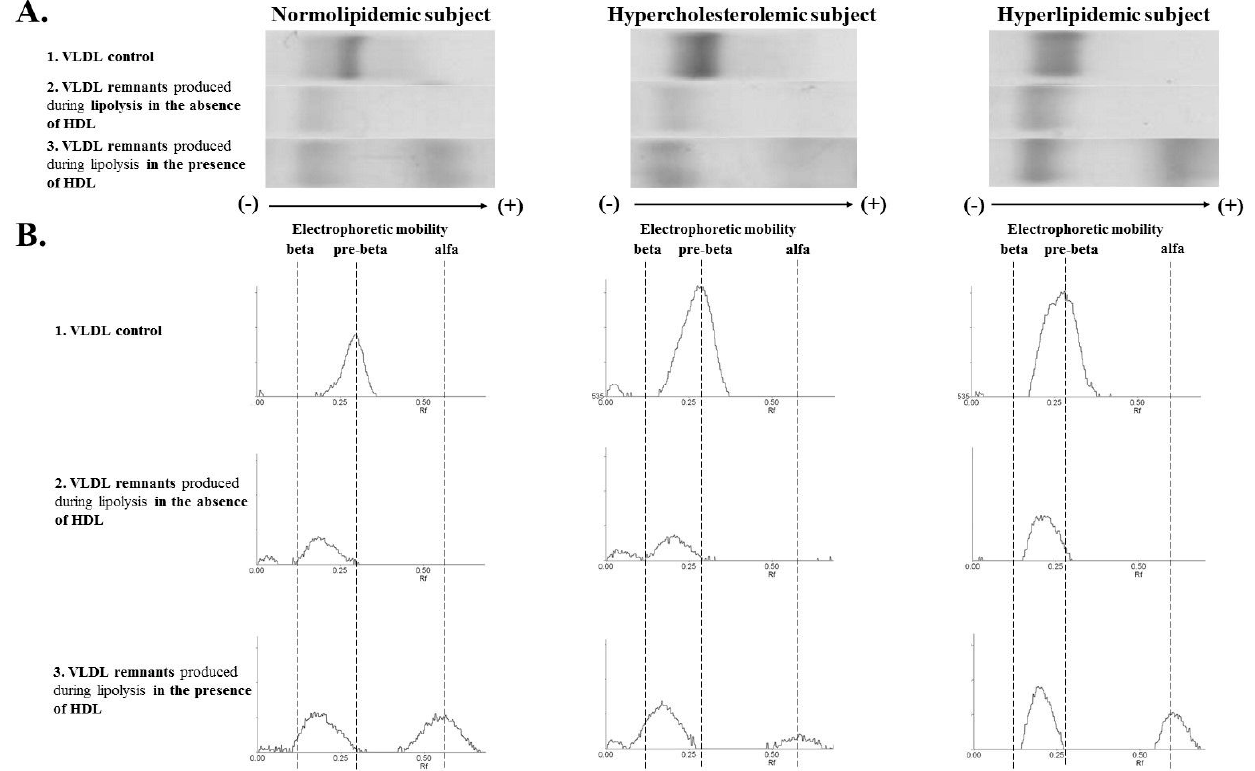
Figure 3. Exemplary electrophoresis ( A ) and electropherograms ( B ) of VLDL control (1) and VLDL remnants produced during LPL-mediated lipolysis in the absence (2) and presence (3) of HDL for normolipidemic (NL), hypercholesterolemic (HC), and hyperlipidemic (HL) subjects.